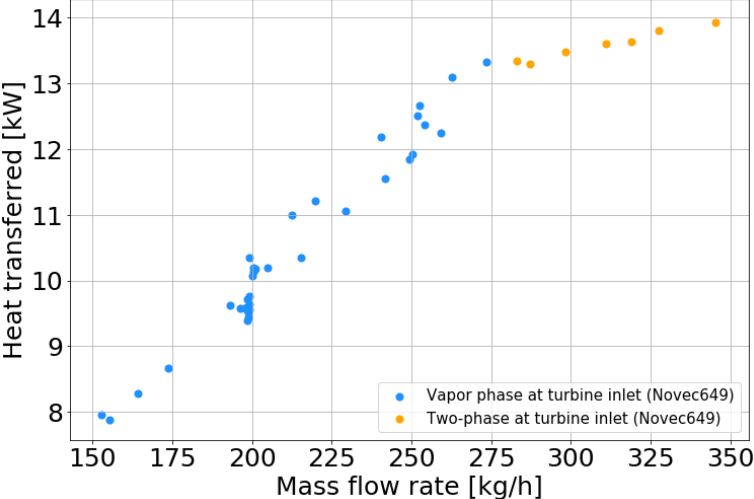
Figure 11. Heat transferred based on the ORC mass flow rate (Novec649 TM ).